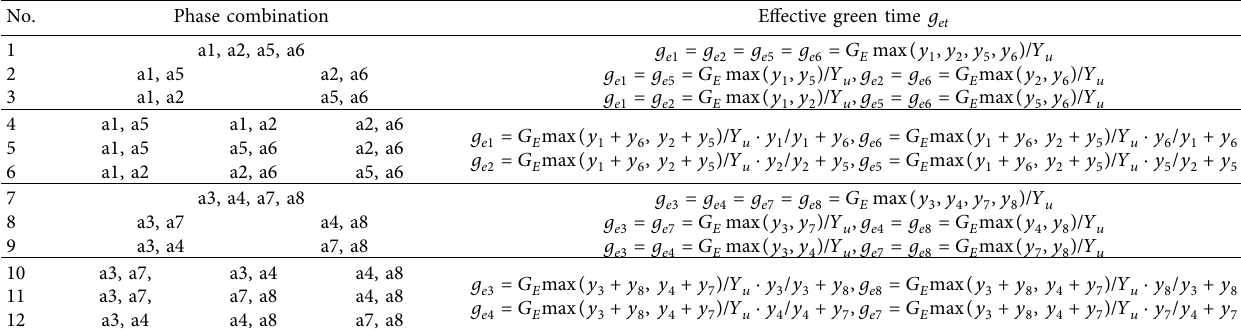
Table 2: Signal timing calculation of diferent phase combinations at intersection.